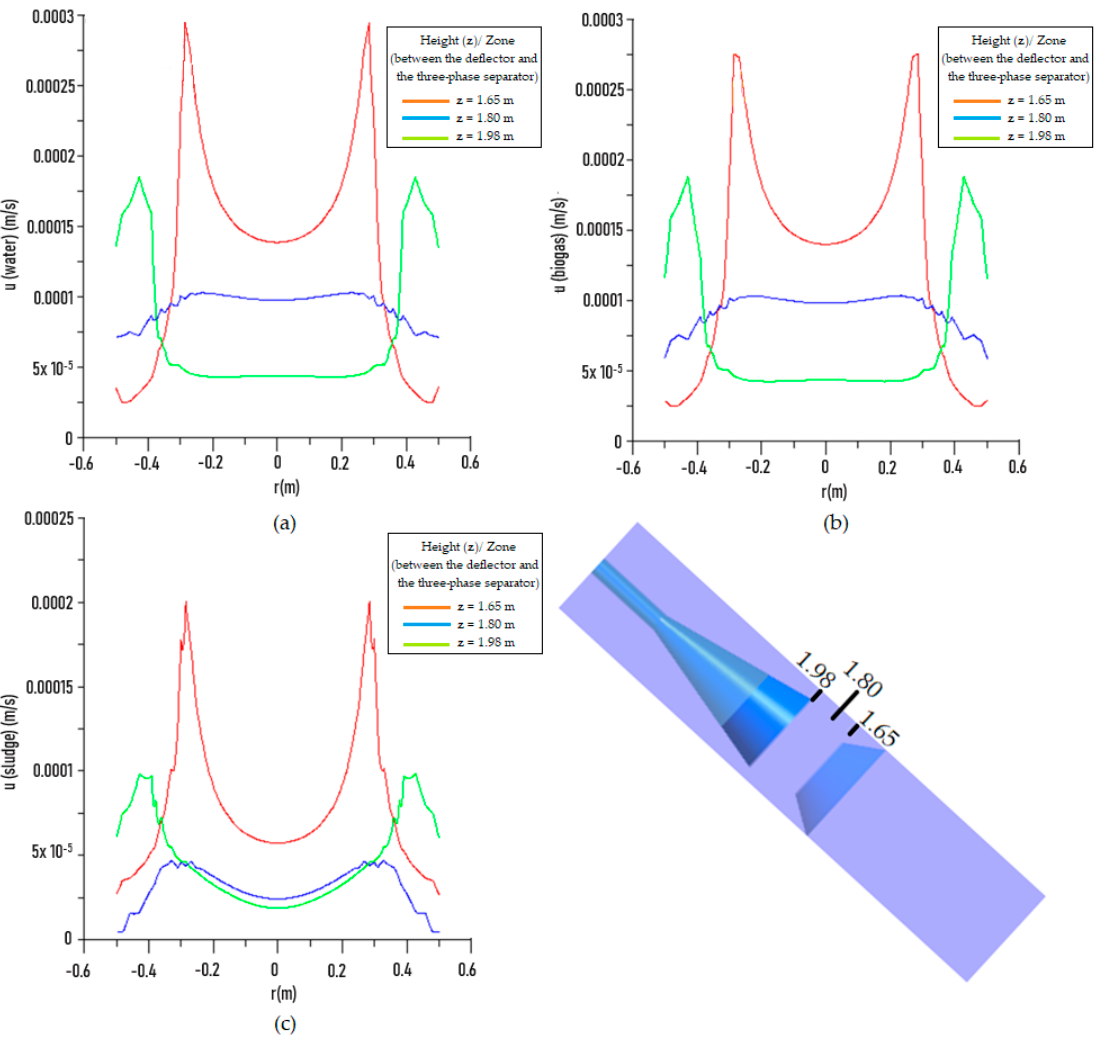
Figure 14. Distribution of the resulting velocity according to the radial position for different axial positions, z, on the region between the deflector and three-phase separator (upward inclination of the deflector): ( a ) water, ( b ) biogas, and ( c ) sludge.